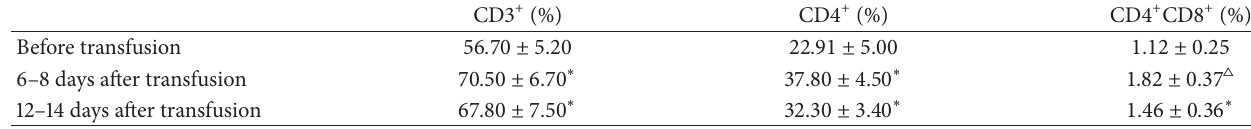
Table 3: Peripheral lymphocyte subsets before and after cytokine-induced killer cell transfusion ( 𝜒 ± 𝑆 ,